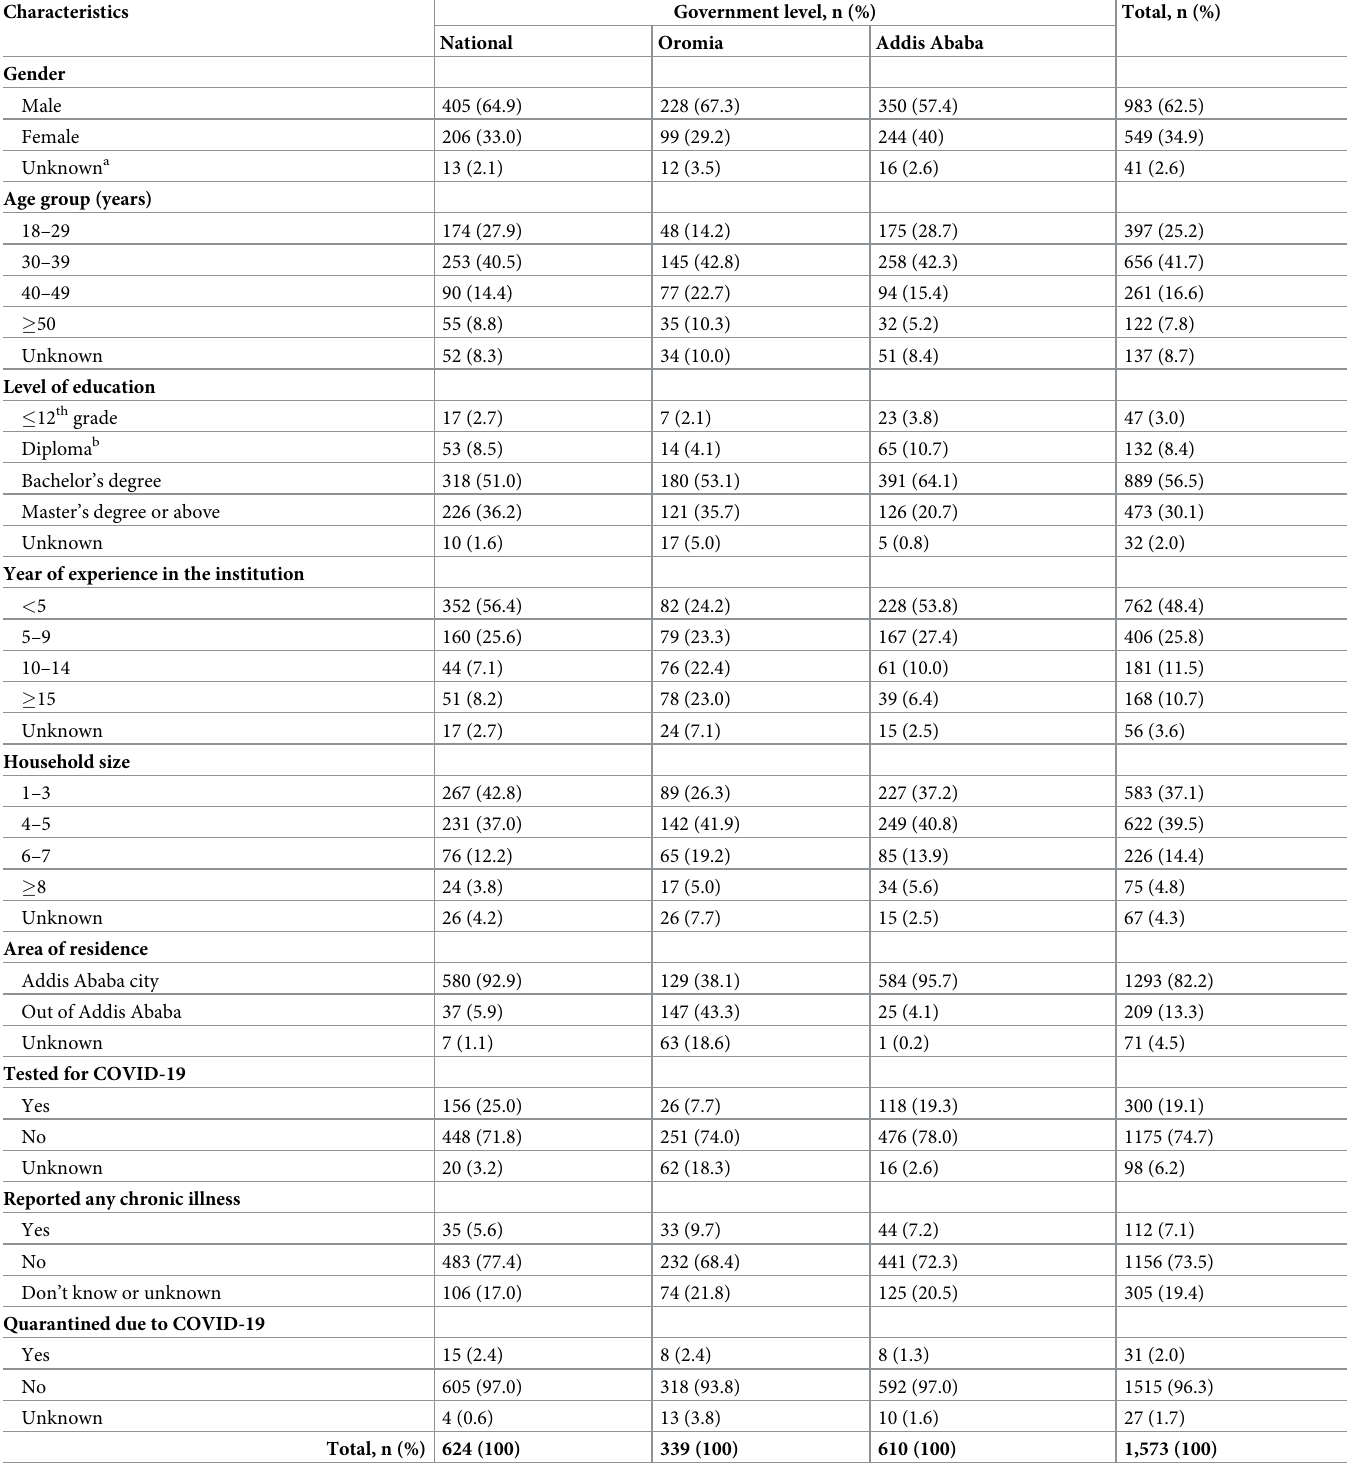
Table 1. Characteristics of study participants by level of government, Addis Ababa, June 2020.